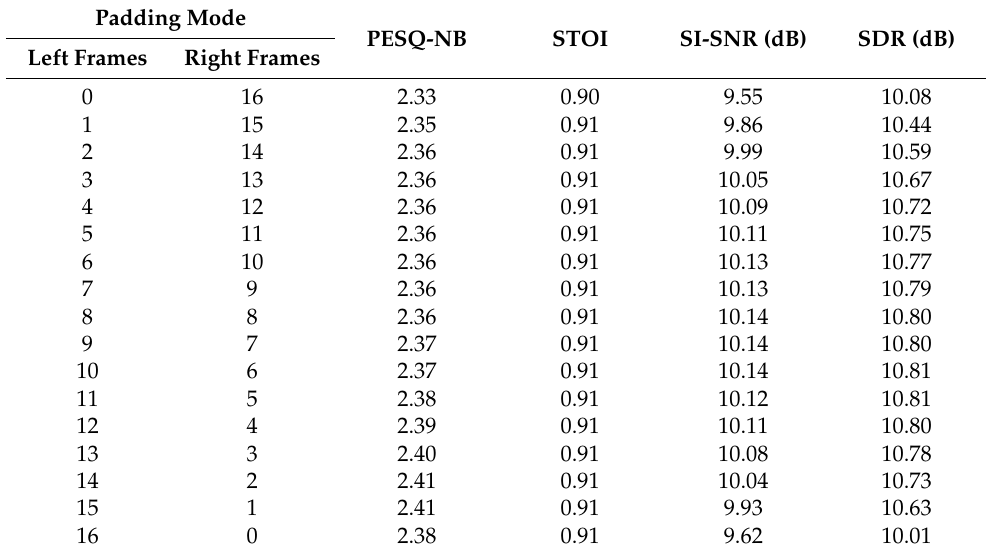
Table 1. The effect of the padding mode on MFMVDR. Padding Mode PESQ-NB